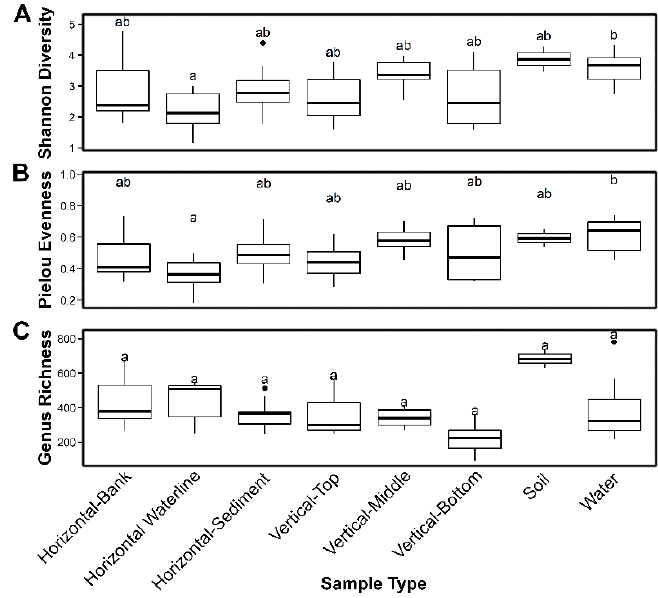
Figure 7. Genus-level statistical measurements of Calumet samples: ( A ) Shannon (alpha) diversity; ( B ) Pielou evenness; and ( C ) richness. Means are marked with a heavy black line, and hinges indicate the first and third quartiles. Whiskers indicate the range of values outside these quartiles. Outliers (farther than 1.5 × the interquartile range) are indicated by black circles. Similarity groups at 95% confidence are indicated by letters a and b.